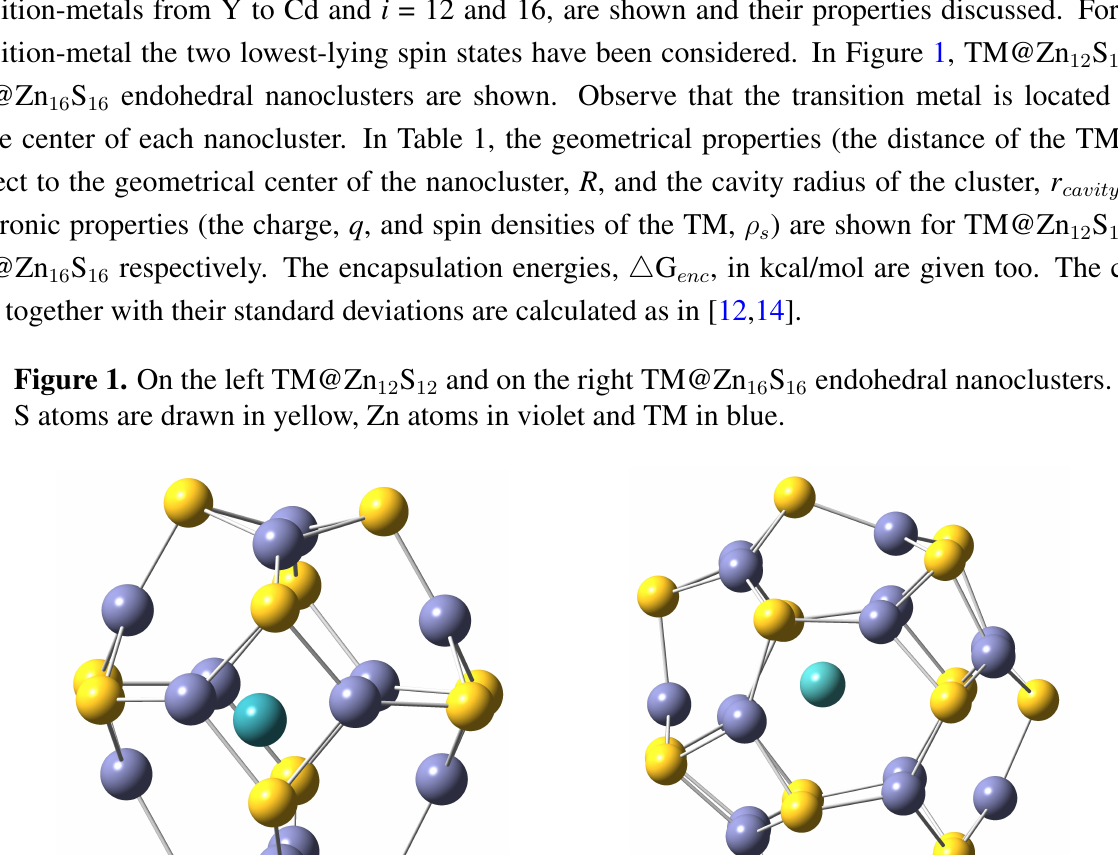
S and on the right TM@Zn 12 12